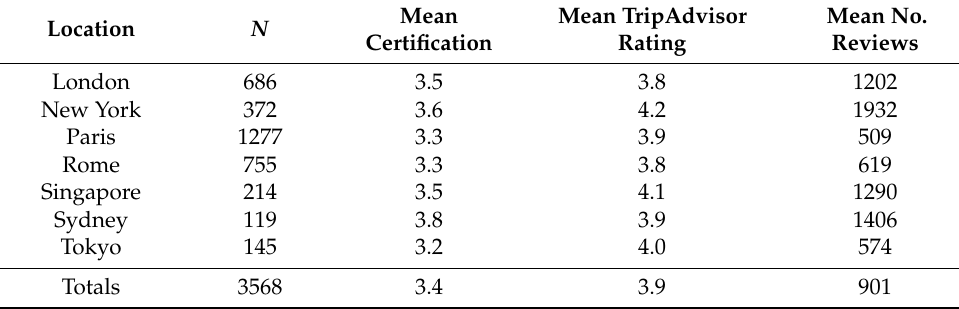
Table 2. Descriptive Statistics–International